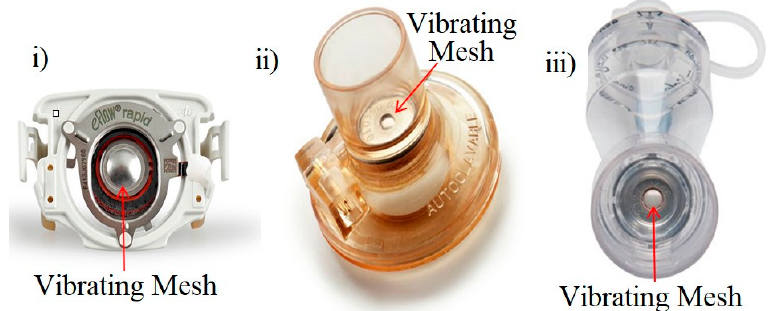
Figure 1. Current vibrating mesh technology. (i) PARI eFlow rapid vibrating mesh nebuliser [68]. (ii) Aerogen Aeroneb Pro vibrating mesh nebuliser [66]. (iii) Aerogen Solo II vibrating mesh nebuliser [66].